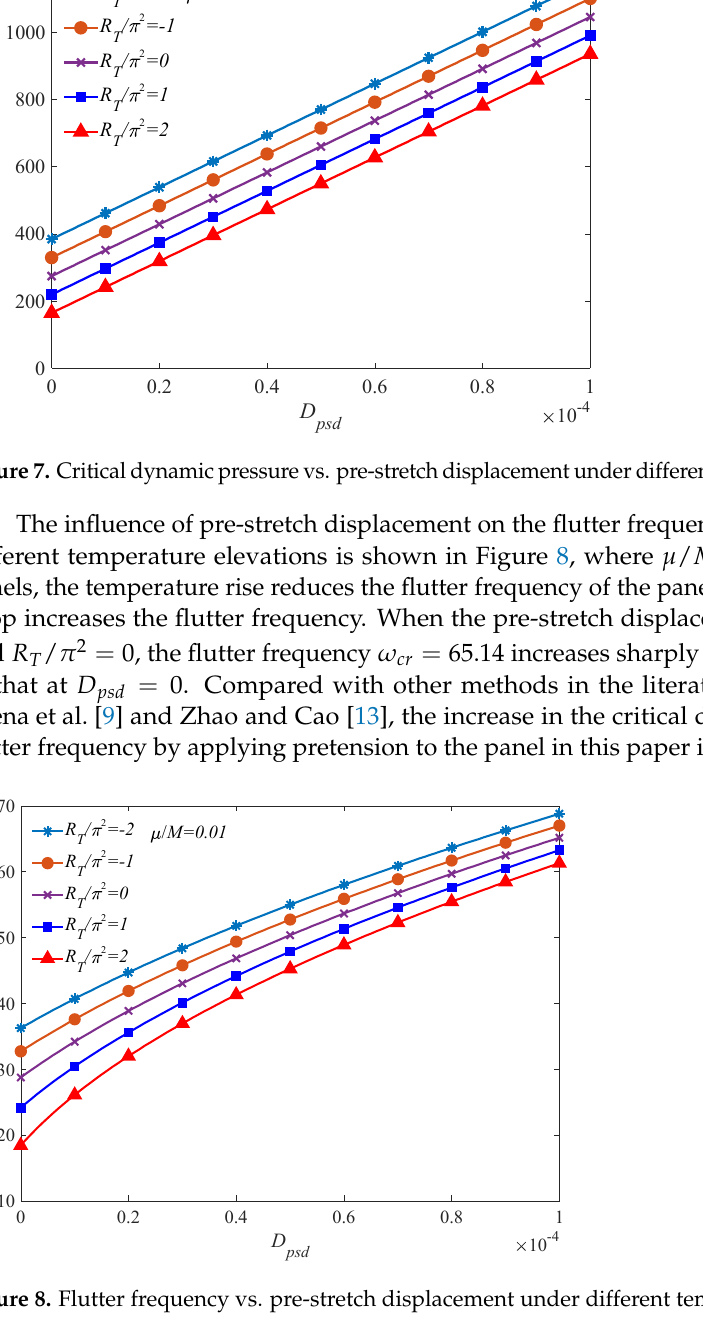
Figure 8. Flutter frequency vs. pre-stretch displacement under different temperature elevations.